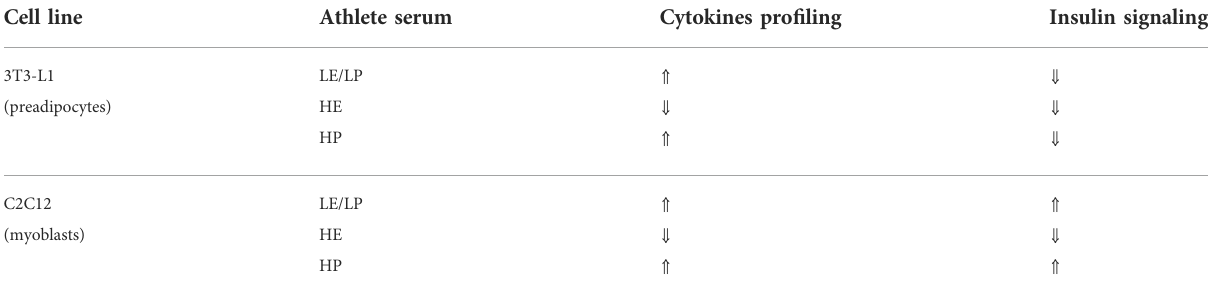
TABLE 2 Summary of changes in secreted cytokines and insulin activation in preadipocytes (3T3-L1) and progenitor skeletal muscle cells (C2C12) treated with 10% of sera from different athlete groups (LE/LP: low endurance/low power, HE: high endurance, and HP: high power). Cell